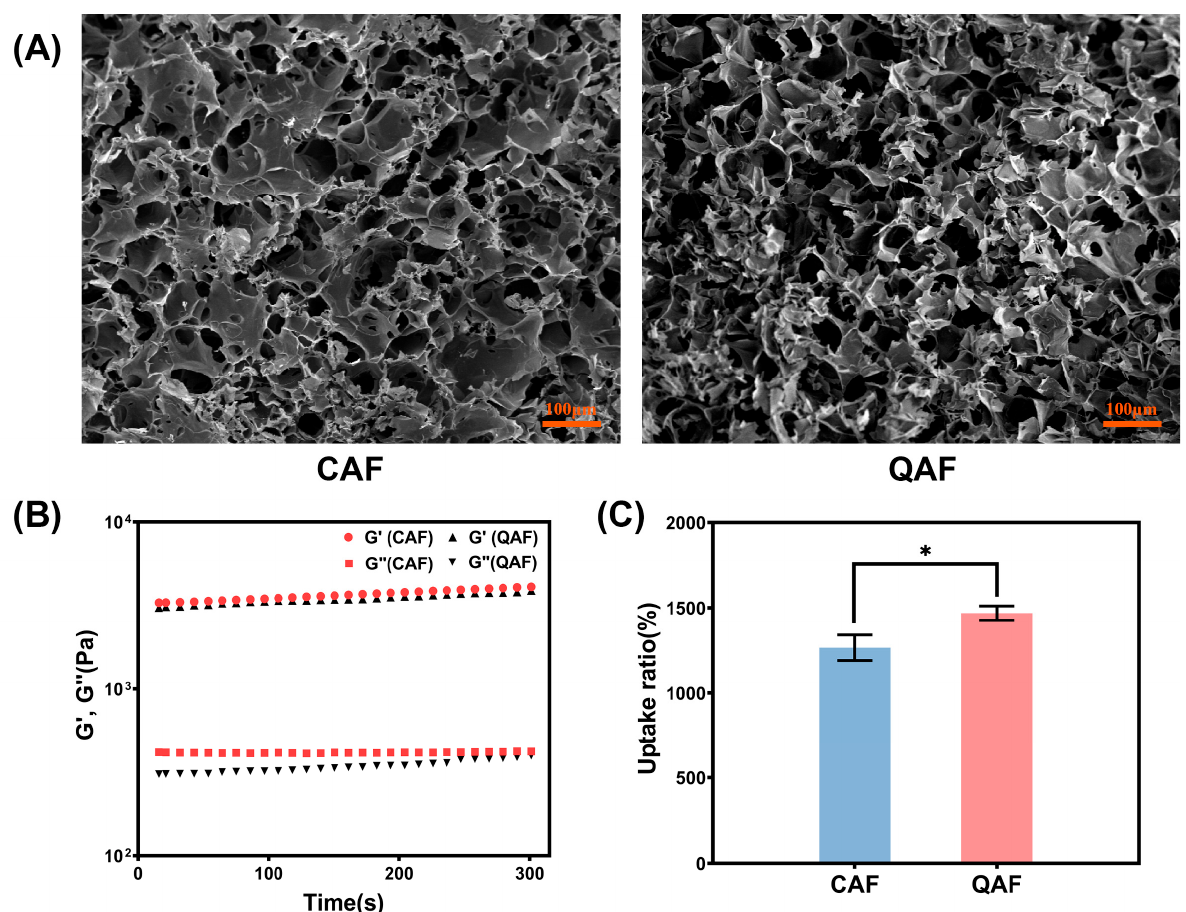
Figure 3. ( A ) SEM images, ( B ) rheological properties and ( C ) uptake ratios ( n = 3) of QAF hydrogels and CAF hydrogels. * p < 0.05.